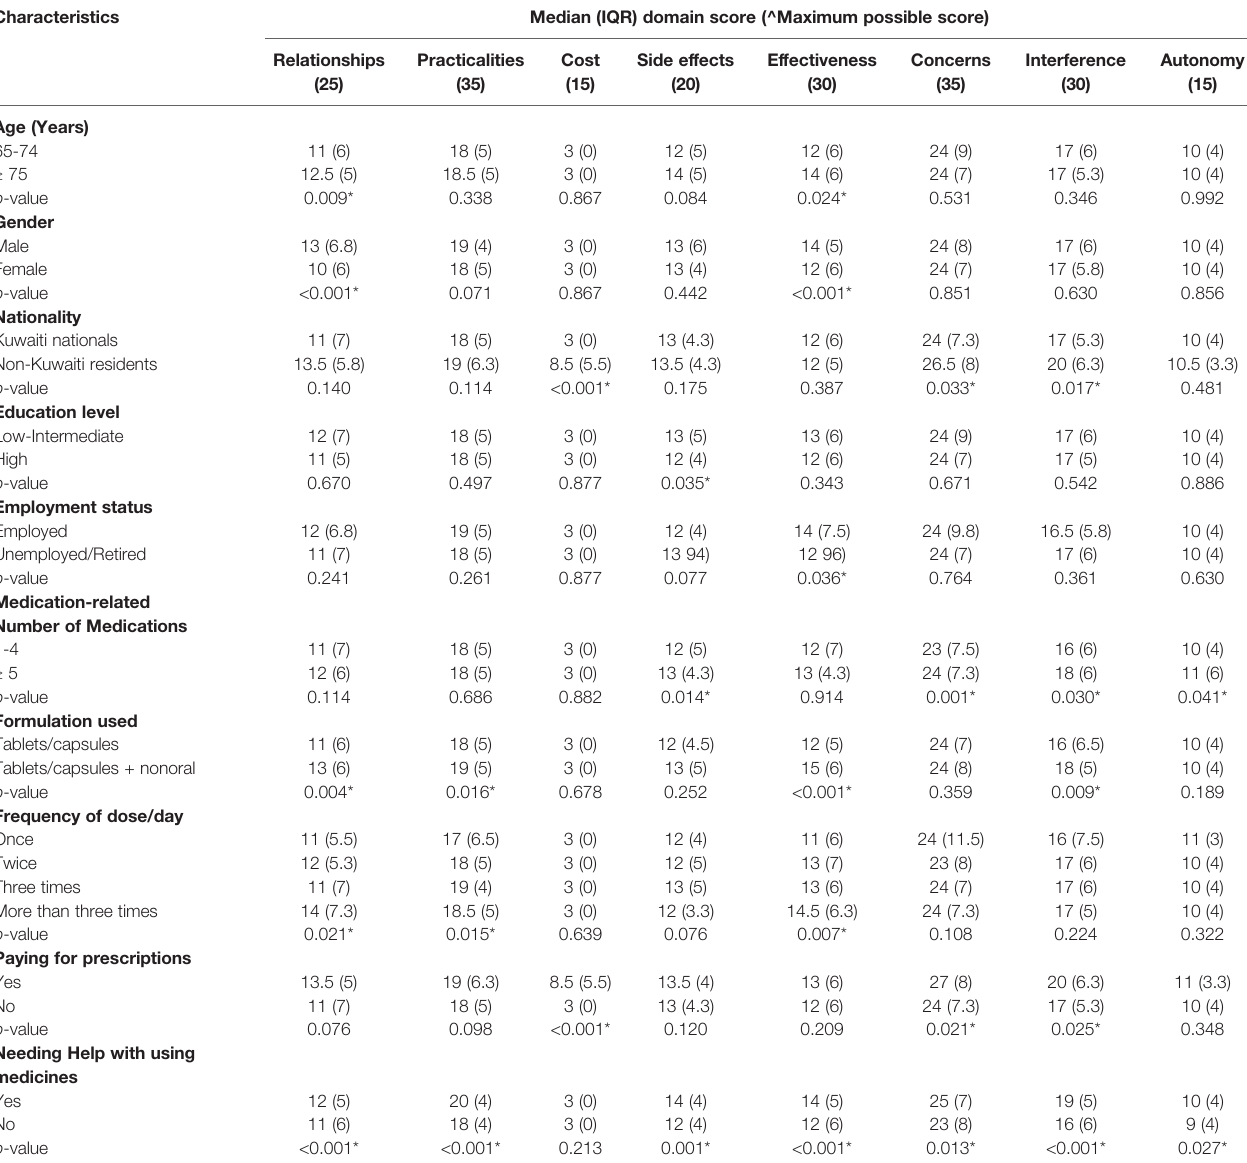
TABLE 3 | Effect of demographic and medication-related characteristics of respondents on individual domains of Living with Medicines Questionnaire version-3 (LMQ ‐ 3) (n=424).